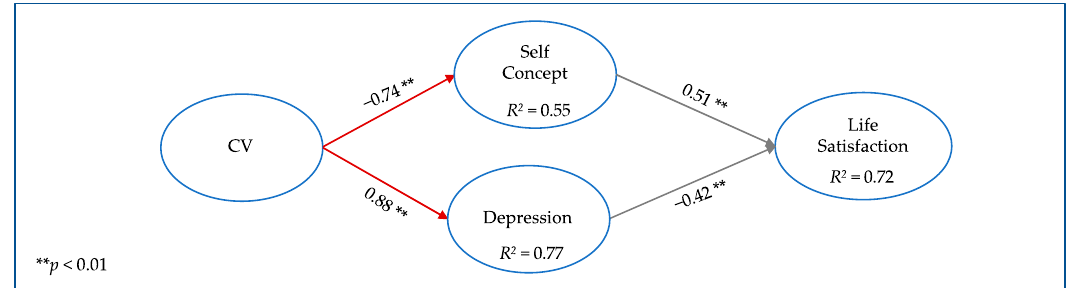
Figure 1. Model 1: Relationships between cybervictimization (CV) and emotional adjustment constructs.